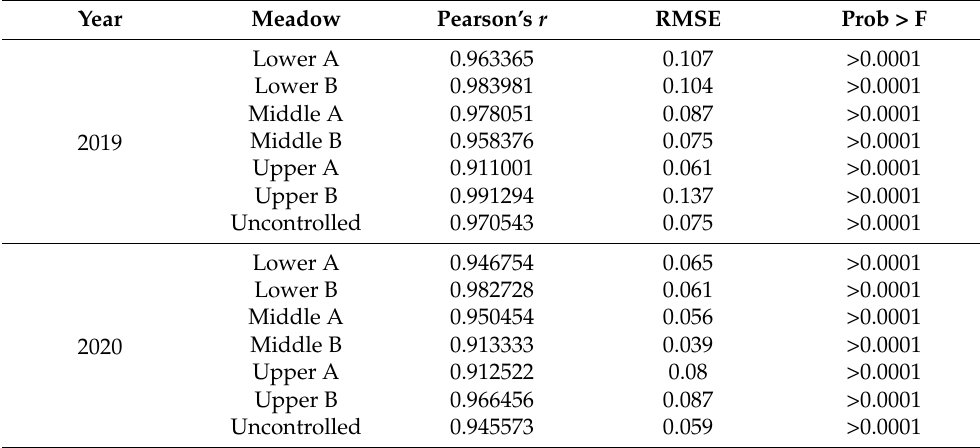
Table 5. Root mean square error (RMSE) and Pearson’s correlation coefficient ( r ) between phenocam GCC and Landsat NDVI for all meadow areas.